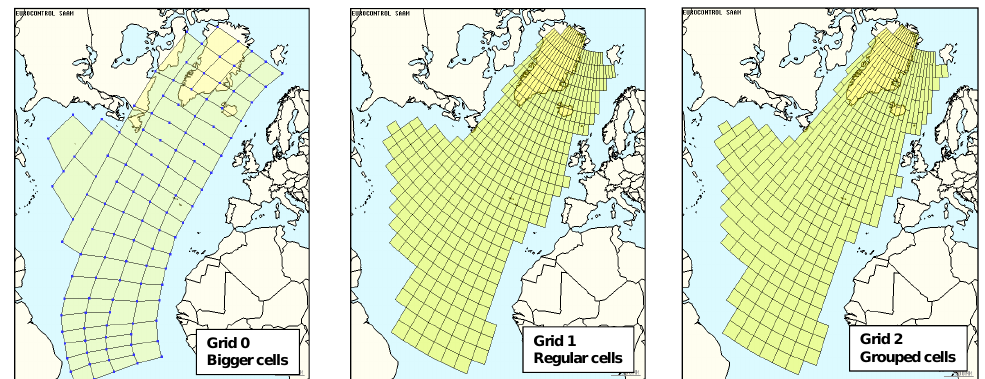
Fig. 4. Different SAAM grid resolutions for route